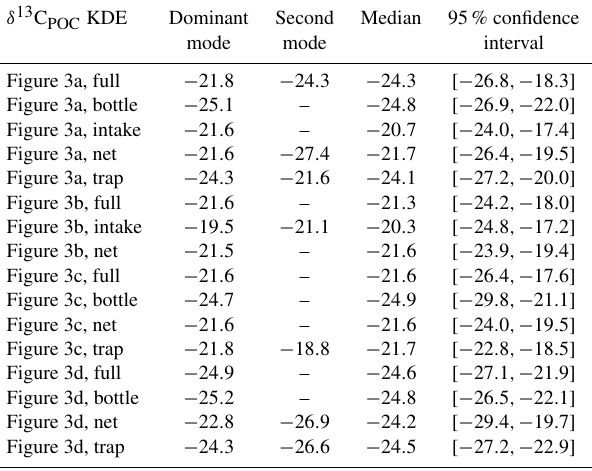
Table A2. Statistical properties of the KDEs derived for Fig. 3 eval- uated on an equidistant grid over [− 35 , − 15 ] with 1001 grid points: the first column indicates the respective KDE, the following two its modes, the fourth the median and the fifth the 95% confidence interval of the respective KDE. All values are given in per mill.